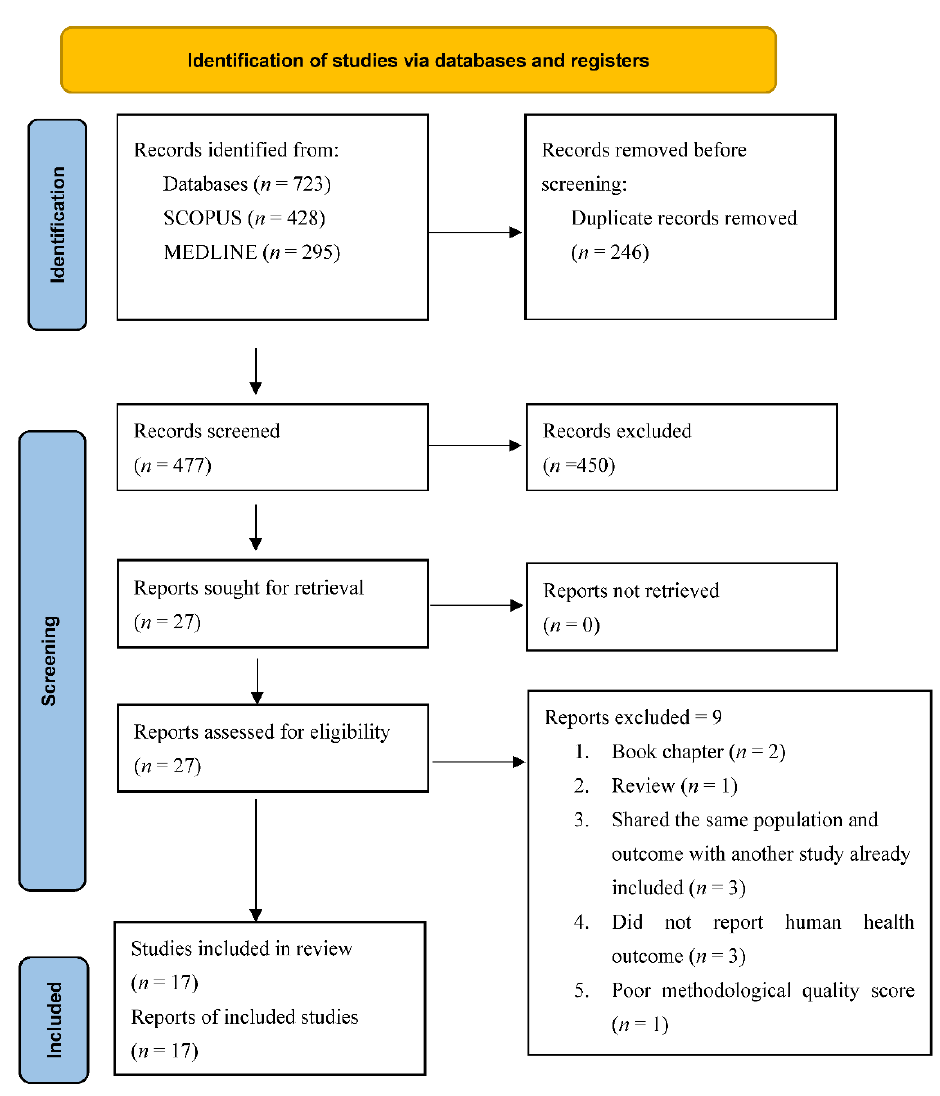
Figure 1. PRISMA flow chart illustrating the process of selecting the studies included in the re- view .